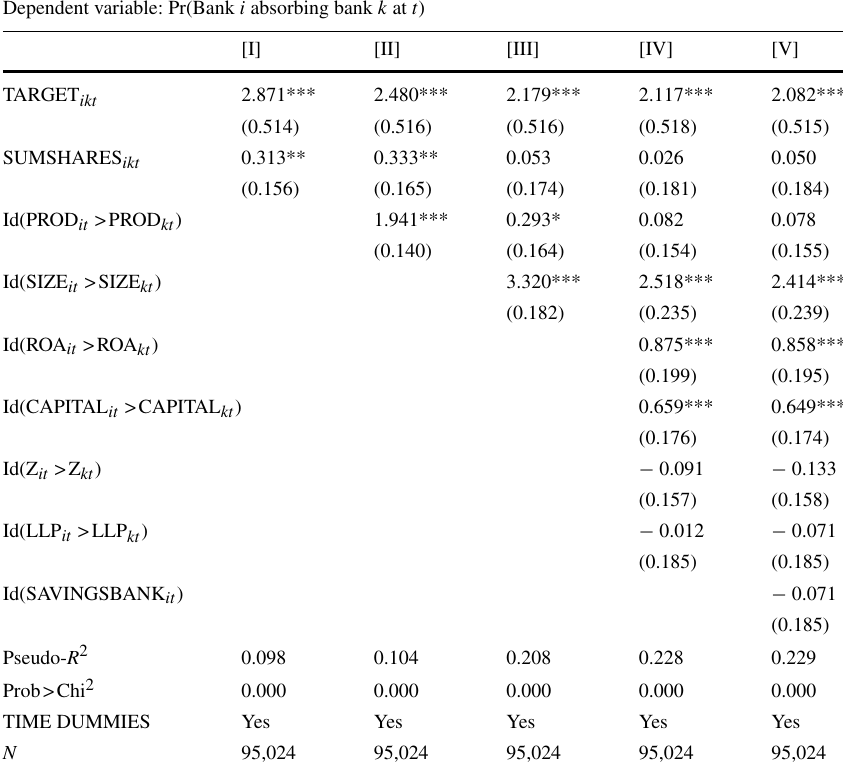
Table 5 Probability of absorbing another